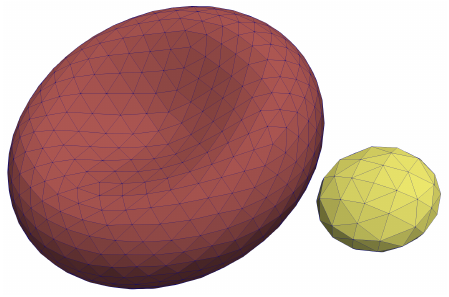
Figure 1. Numerical cell meshes used in the simulations: ( Left ) a red blood cell; and ( Right ) a